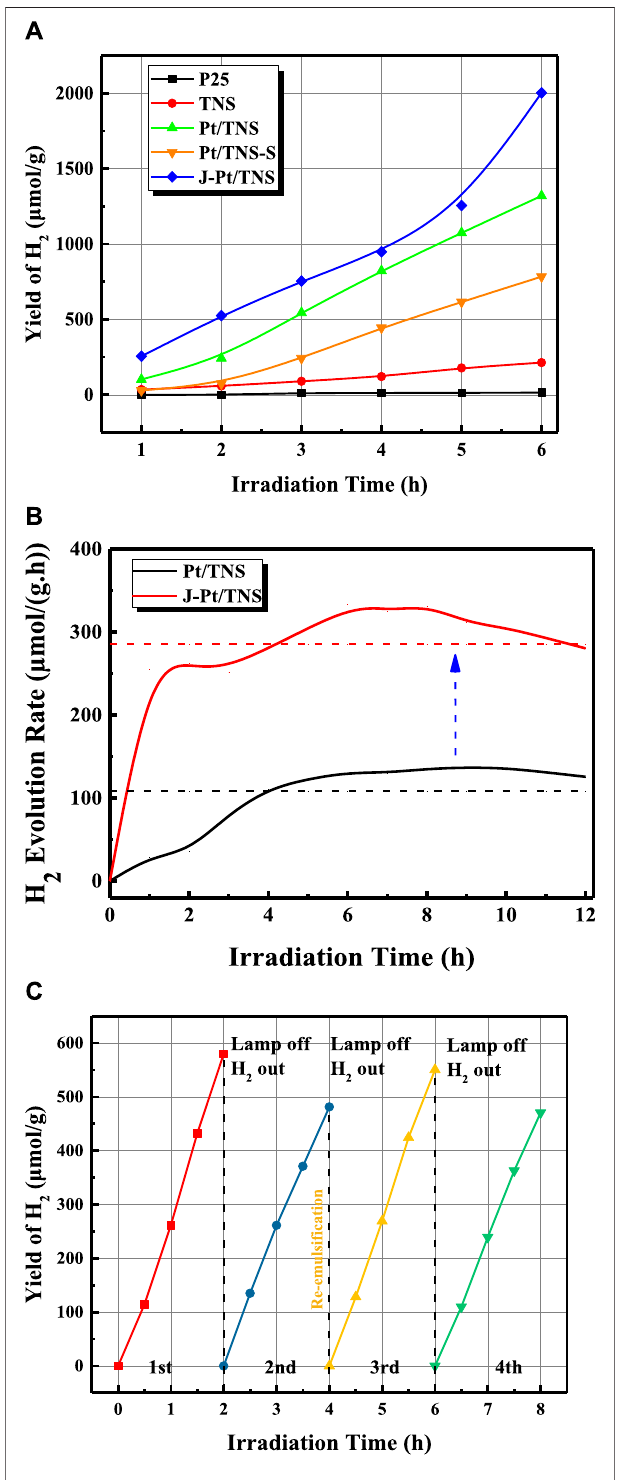
FIGURE 9 | Diagram of (A) yield of H 2 of P25, TNS, Pt/TNS-S, Pt/TNS, and J-Pt/TNS in 6 h, (B) hydrogen evolution rate of Pt/TNS and J-Pt/TNS in 12 h, and (C) cyclic performance of Pickering interfacial catalytic hydrogen production over J-Pt/TNS.